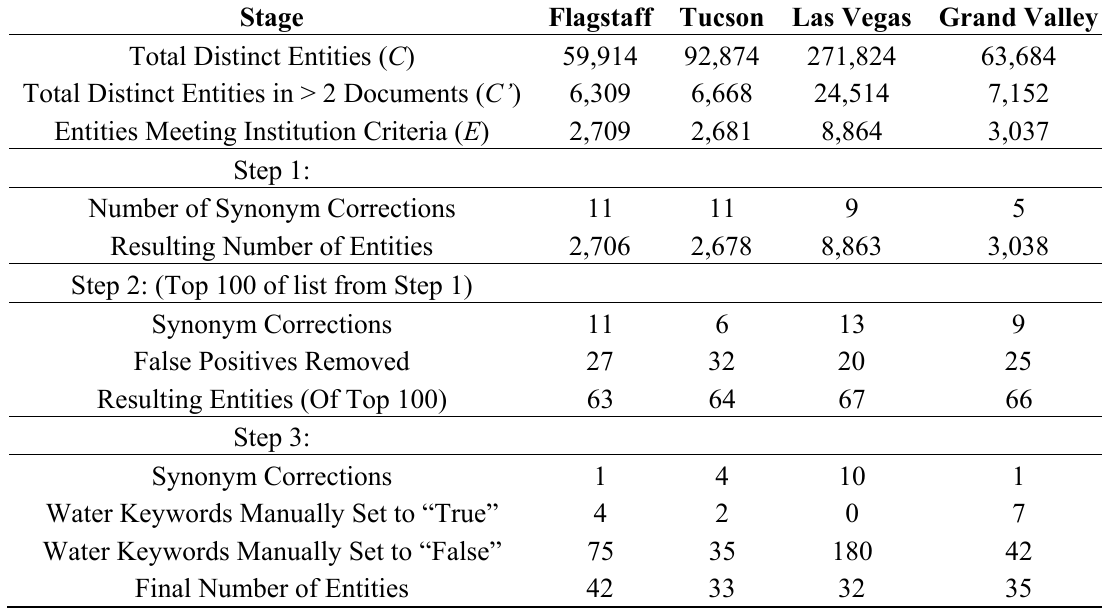
Table 5. Numbers of entities and removals at each stage of the analysis processes.